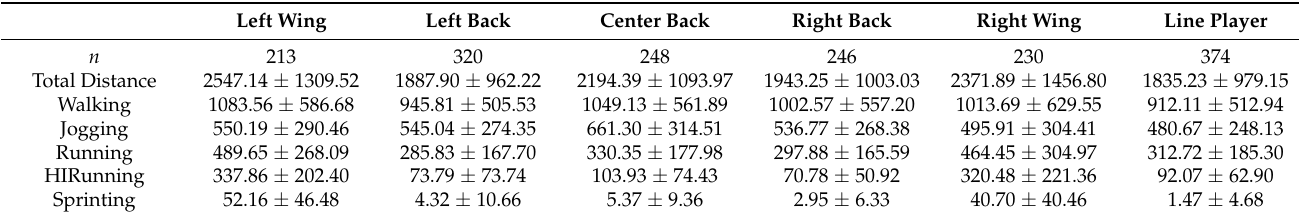
Table 3. Total distance covered in different locomotion categories by playing